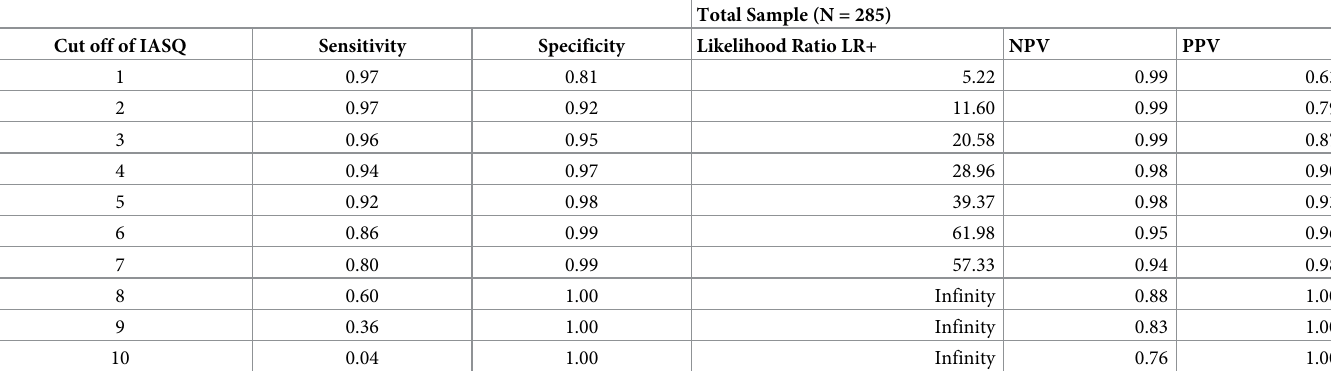
Table 2. Sensitivity and specificity of IASQ with CARS2 (ST+HF) (n = 285).